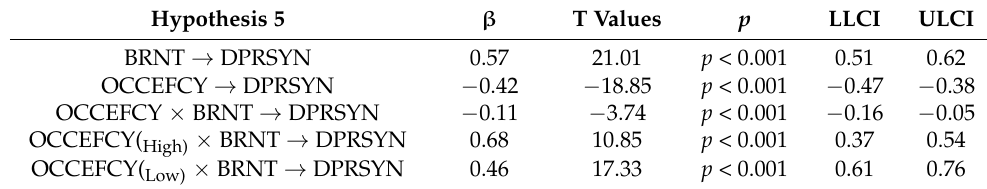
Table 7. Moderation analysis result.